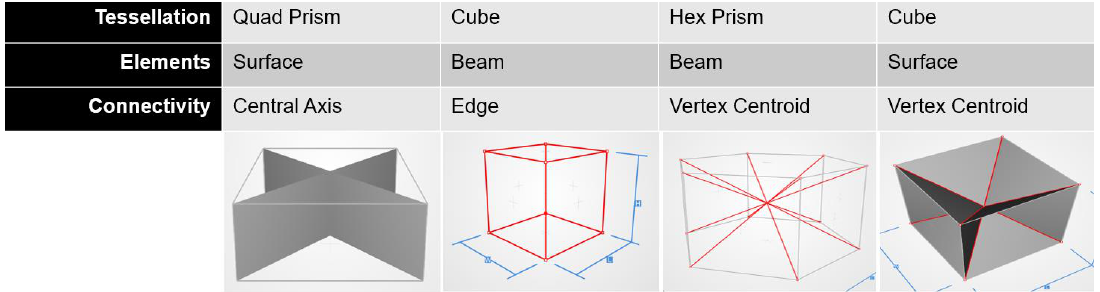
Figure 2. Four examples of how the three design decisions in Figure 1 translate into the realization of cellular shape designs.